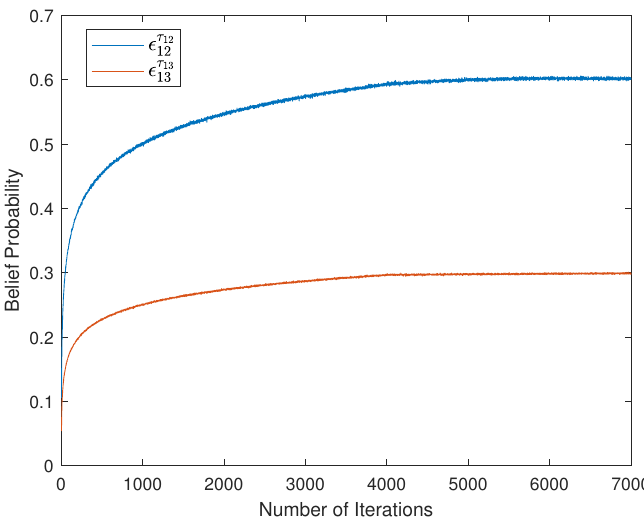
τ ij of MG 1 about EVs 2 and 3 versus number ij